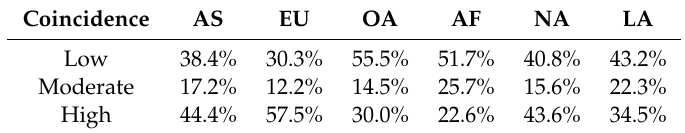
Table 2. The percentages of coincidence levels of the cropland spatial distribution on six continents. Coincidence AS EU OA AF